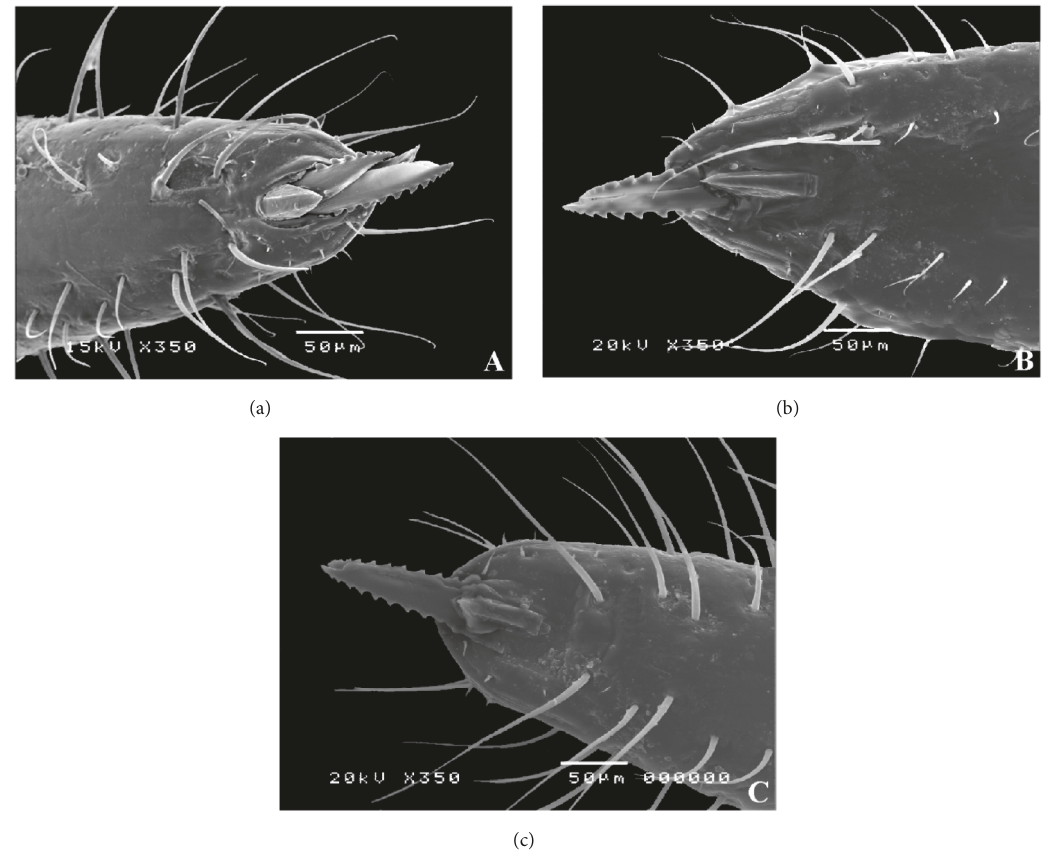
Figure 2: Micrography of the apex rostrum male. (a) Triatoma carcavalloi . (b) Triatoma circummaculata . (c) Triatoma rubrovaria .